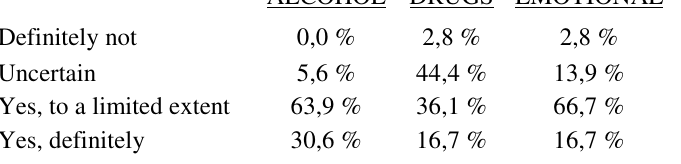
PERCEIVED PREVALENCE OF